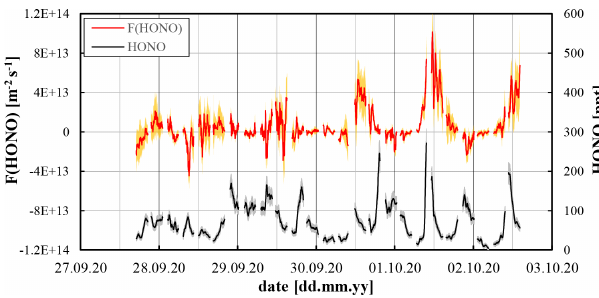
Figure 5. HONO mixing ratios and HONO fluxes (30min running mean data) in Melpitz. The grey and orange shaded areas reflect the accuracy of the